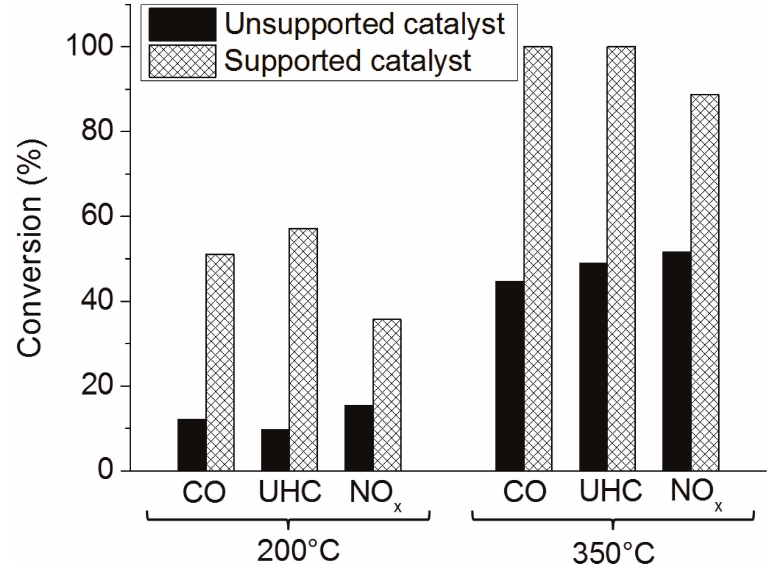
Figure 13. Comparison of CO, UHC, and NO conversions obtained on unsupported and x supported La Sr Mn Pt O washcoated cordierite honeycomb monoliths. Adapted 0.7 0.3 0.95 0.05 3 from Labhsetwar et al.